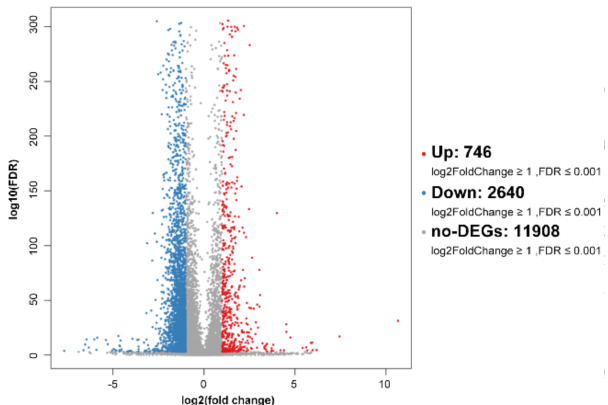
Figure 7. Volcano plot of global gene expression profile after SPPH treatment. Down- (blue dots) and up-regulated genes (orange dots) are presented as differentially expressed genes (DEGs).